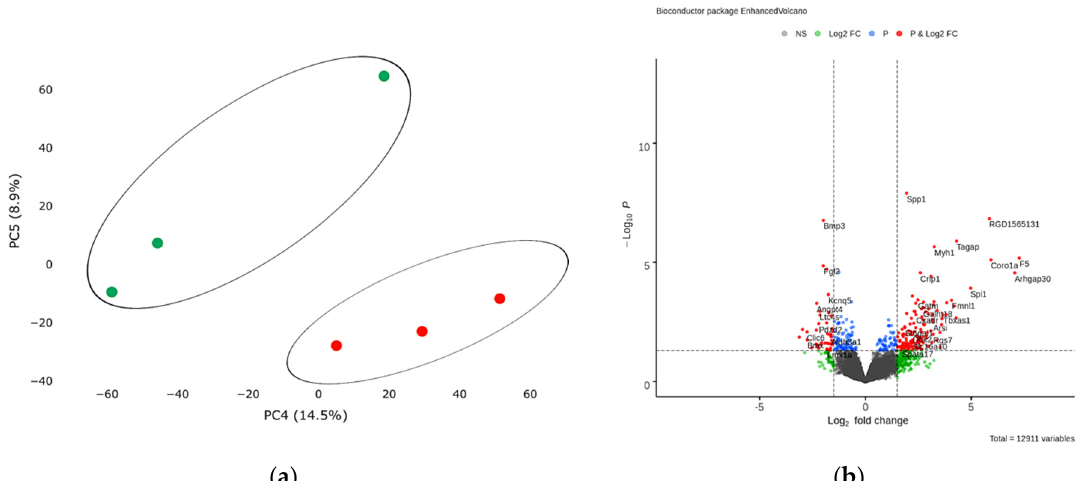
Figure 5. ( a ) Principal component analysis (PCA) displays variability in gene expression in healthy (green dots, n = 3) and postinfarction (orange dots, n = 3) CMCs using the Phantasus Web Tool. Major component 1 (PC4) on the x -axis and PC5 on the y -axis accounted for 14.5% and 8.9% of the total variability in gene expression, respectively. The samples are visually divided into two main groups. ( b ) Volcano plots showing differentially expressed genes ( p -value < 0.05) in post-infarction samples compared to controls, performed using Bioconductor software in R. The y -axis corresponds to the mean expression value of -log10 ( p -value), and the x -axis displays the log2 (fold-change) value. The red dots represent significantly differentially expressed genes.